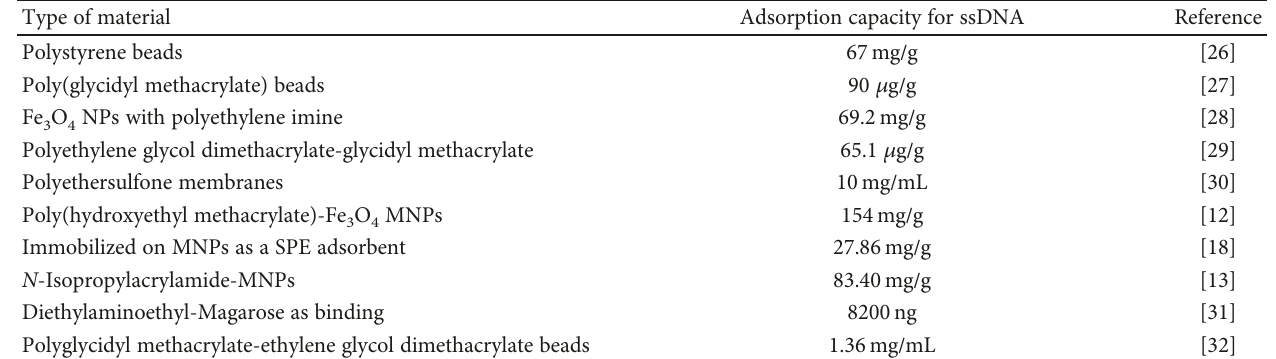
Table 6: Comparison of the adsorption capacities for ssDNA from